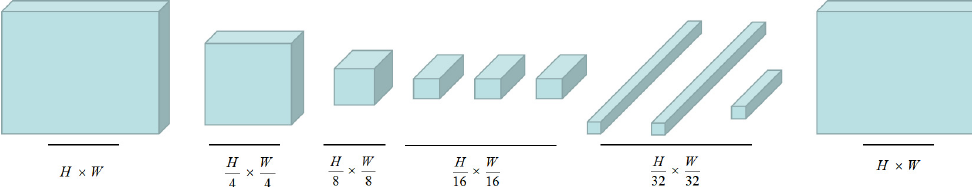
Figure 2. The size of the image input in fully convolutional network (FCN) is H × W. After each pooling, the size of the feature map will become smaller accordingly. Transforming fully connected layers into convolution layers enables a classification net to output a H × W heatmap. Adding the deconvolution layers produces an efficient network for end-to-end dense learning.